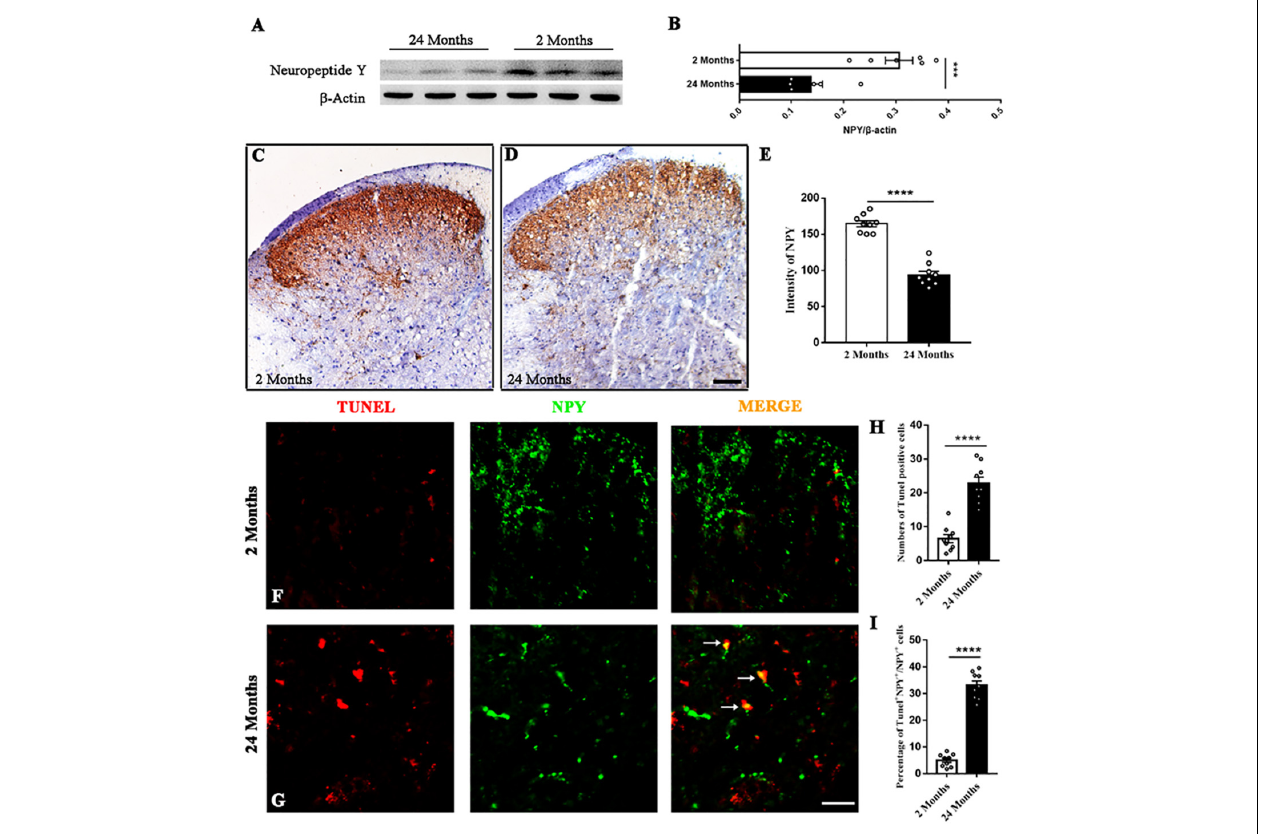
FIGURE 1 | The degeneration of spinal NPY in aged mice. (A,B) Aging down-regulated NPY in the spinal dorsal horn. Six mice in each group, **** P < 0.0001, 2 (3 male and 3 female) versus 24 months (3 male and 3 female), Student’s t -test. (C,D) The distribution of NPY in the spinal dorsal horn of young (C) and aged (D) mice. Scale bar: 100 µ m. (E) Quantitative analysis of NPY intensity indicated the degenerated spinal NPY in aged mice compared with the young mice. Nine slices from 3 mice in each group, *** P < 0.001, 2 (2 male and 1 female) versus 24 months (2 male and 1 female), Student’s t -test. (F,G) Colocalized cells (yellow, arrows) by TUNEL (red) and NPY (green) fluorescence in young and aged mice. Scale bar: 50 µ m. (H) The number of TUNEL + cells in each dorsal horn of young and aged mice. Nine slices from 3 mice in each group, **** P < 0.0001, 2 (2 male and 1 female) versus 24 months (2 male and 1 female), Student’s t -test. (I) The percentages of TUNEL + cells among NPY + cells in the spinal dorsal horn of young and aged mice. Nine slices from 3 mice in each group, **** P < 0.0001, 2 (2 male and 1 female) versus 24 months (2 male and 1 female), Student’s t